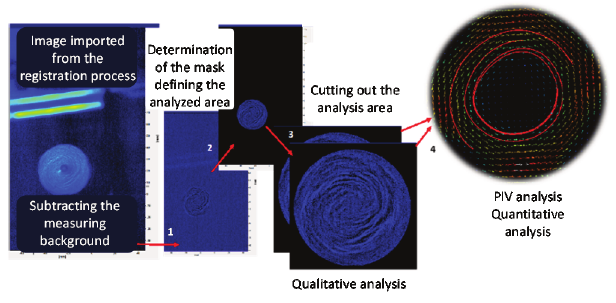
Fig. 12. Streak method test results processing